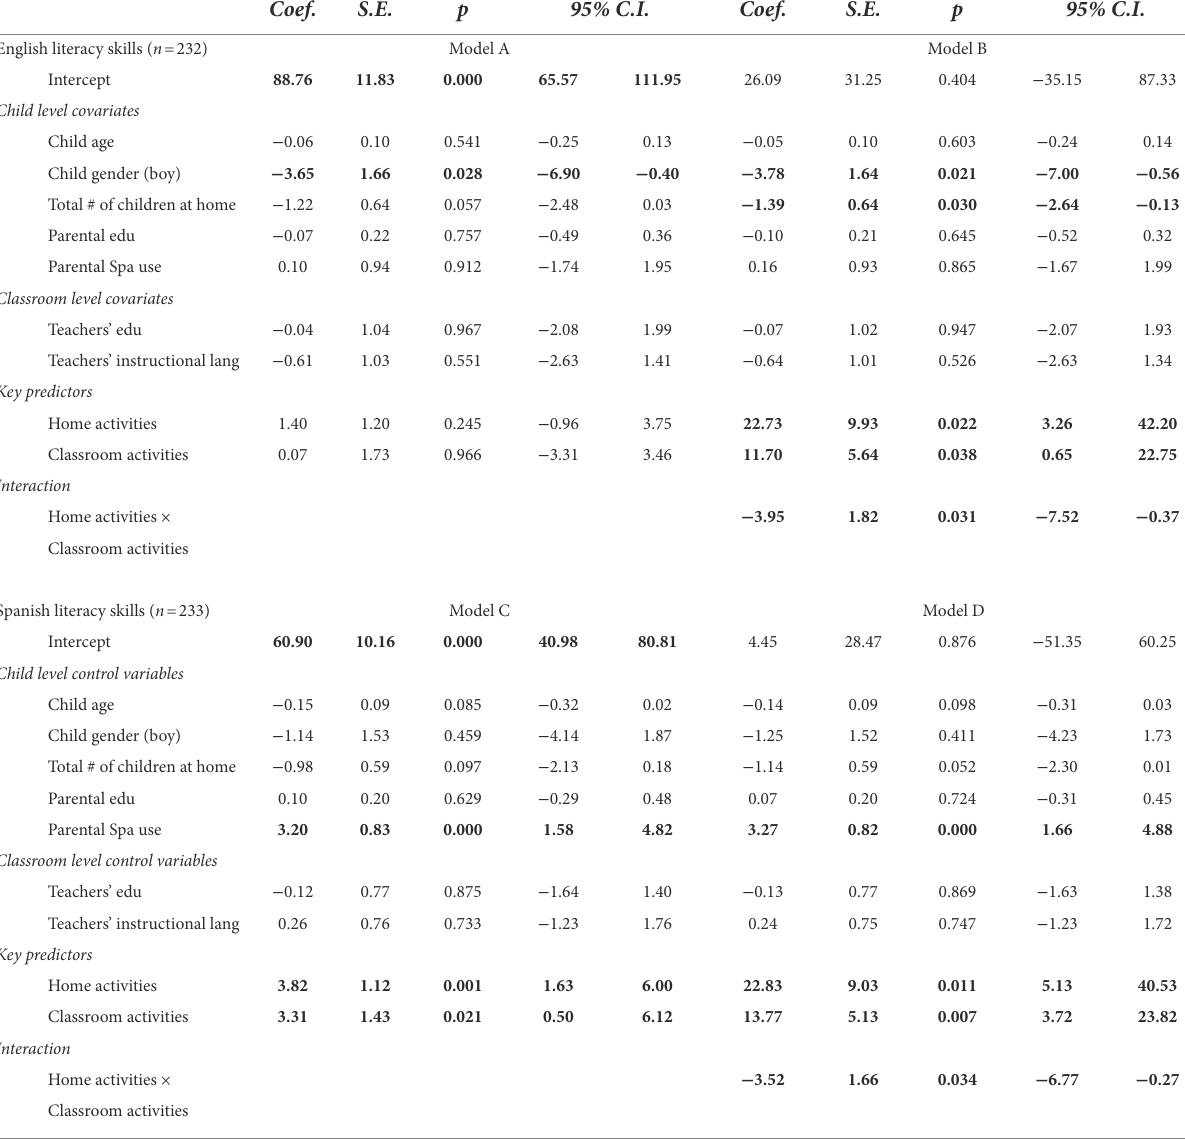
TABLE 2 Home and classroom language and literacy activities predicting emergent literacy skills in English and Spanish.